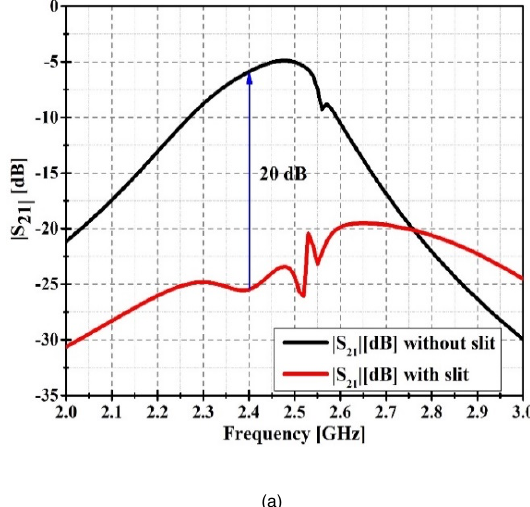
FIGURE 7. Gain of proposed Antenna (a) Without AMC-backing (b) With AMC-backing